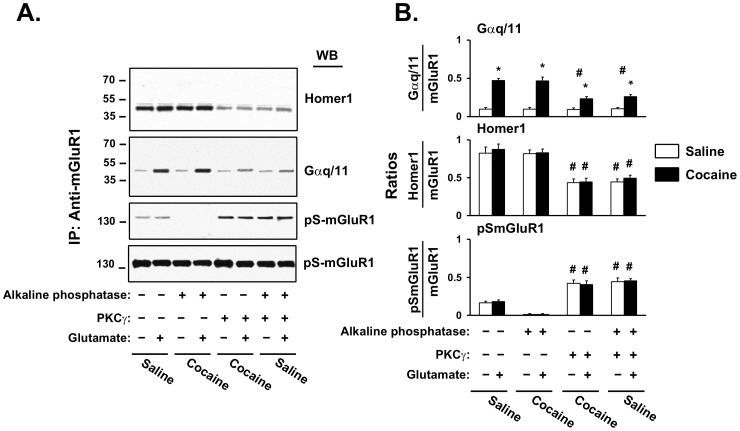
Heightened PKC-mediated serine phosphorylation of mGluR1 in prenatal cocaine- exposed brains is responsible for the reduced mGluR1 coupling to Gq/11 and Homer1.(A) Levels of mGluR1 - Gq/11 and mGluR1 - Homer1 coupling as well as serine-phosphorylated mGluR1 (pS-mGluR1) on purified mGluR1 signaling complexes. FCX synaptosomal membranes from prenatal cocaine- and saline-exposed P21 rats were incubated with either vehicle 100 µM alkaline phosphatase, 30 µM ATP containing Kreb’s-Ringer (K-R) or 162 nM PMA (20 µg phosphoatidylserine). Following completion of dephosphorylation by addition of phosphatase inhibitors, phosphate-free mGluR1 from prenatal saline-treated rats was phosphorylated by recombinant γPKC in the presence of ATP. The reaction was terminated by specific PKC inhibitor, celestrine. The resultant synaptic membranes containing differentially phosphorylated mGluR1 were then incubated with K-R or 1 µM glutamate. The mGluR1 purified by anti-mGluR1 immunoprecipitation was analyzed for phosphoserine by Western blotting. The interaction between mGluR1 and Gq/11 or Homer1 with different phosphorylation states was assessed by the levels of Gαq/11 and Homer1 in the anti-mGluR1 immunoprecipitates by Western blotting. (B) Densitometric quantification of mGluR1-associated Gαq/11 and Homer1 as well as pS-mGluR1 levels. Data are represented as means ± s.e.m. of the ratios of Gαq/11, Homer1 or pS-mGluR1/total mGluR1 optical intensities. n = 4 for each group. *p<0.01 comparing the glutamate-induced to basal mGluR1-Gq/11 complex levels by two-tailed Student’s t test. #p<0.01 comparing the respected levels in prenatal cocaine- to saline-treated rats. No between-group differences in the levels of mGluR1were detected.